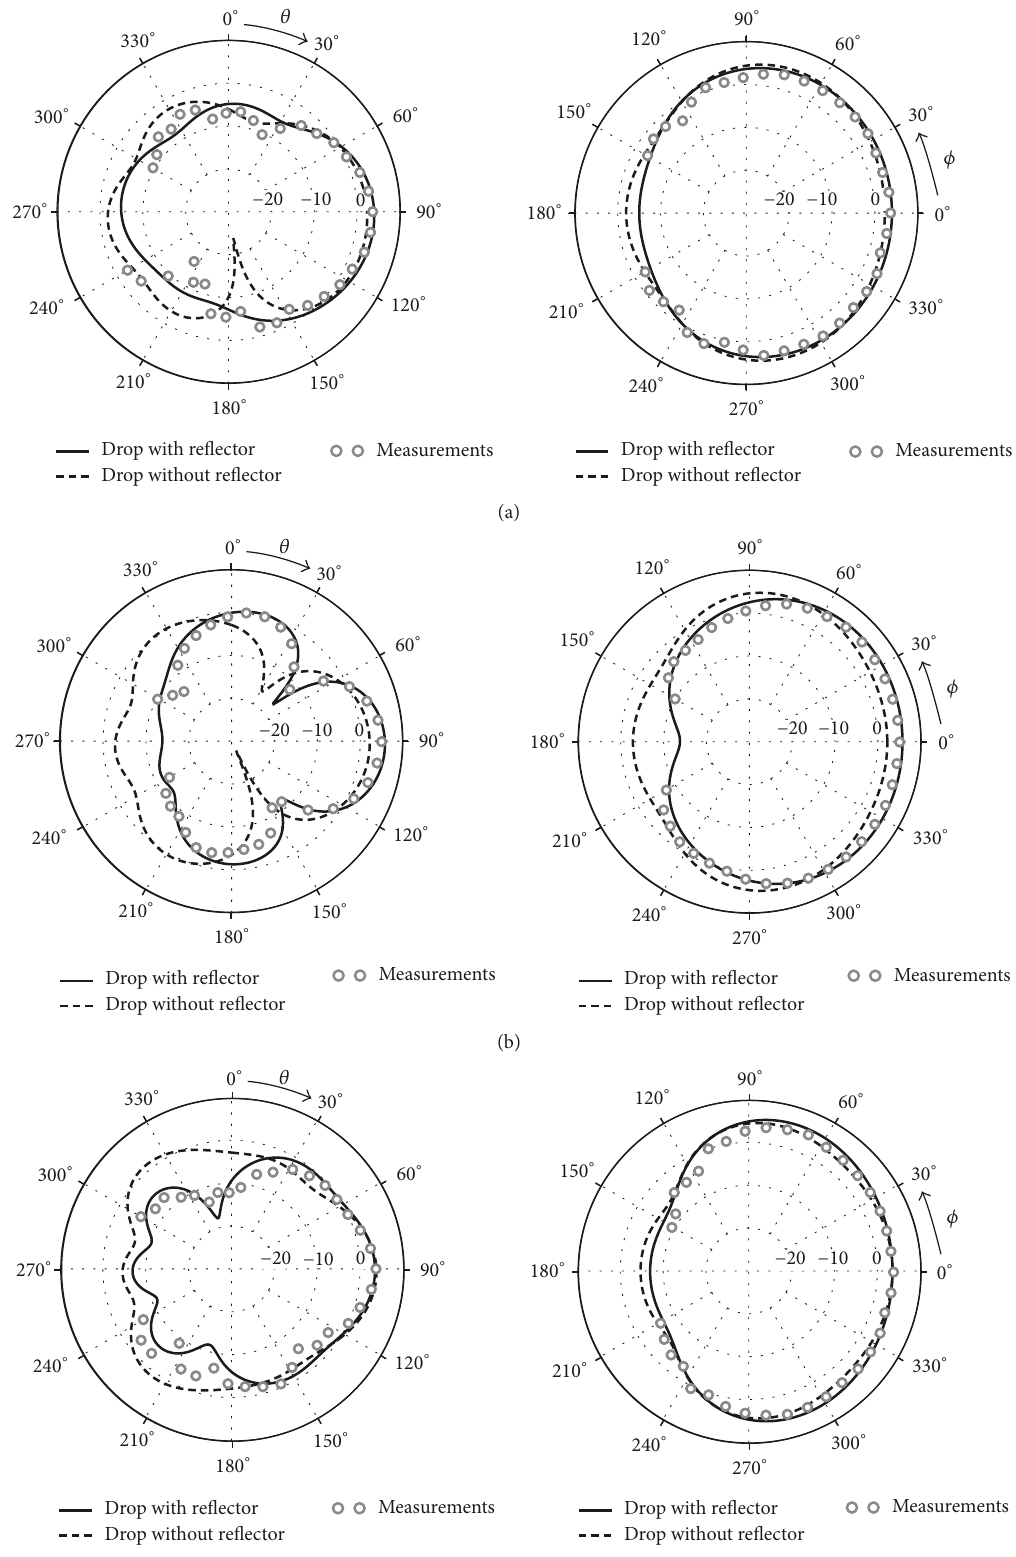
Figure 9: Antenna gain patterns in the 𝐸 -plane (left side) and in the 𝐻 -plane (right side) for the drop-shaped dipole antenna with and without reflector. Working frequency: (a) 5 GHz, (b) 6 GHz, and (c) 7 GHz. An enhanced quasi-traveling wave behaviour is observed in the radiation patterns relevant to the drop-shaped dipole antenna equipped with the metal